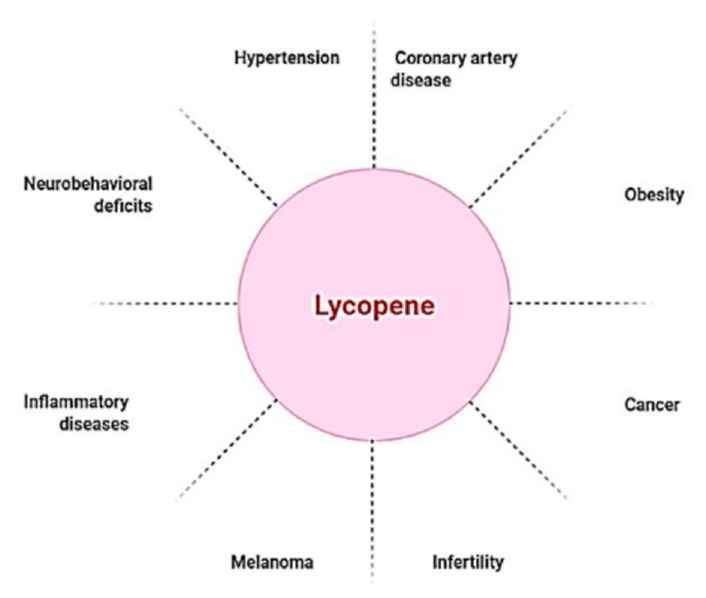
Figure 1. Lycopene as a nutraceutical compound has applications against multiple diseased conditions.